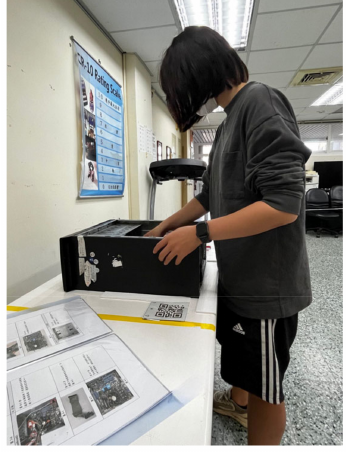
Figure 11. Job instruction on a printed